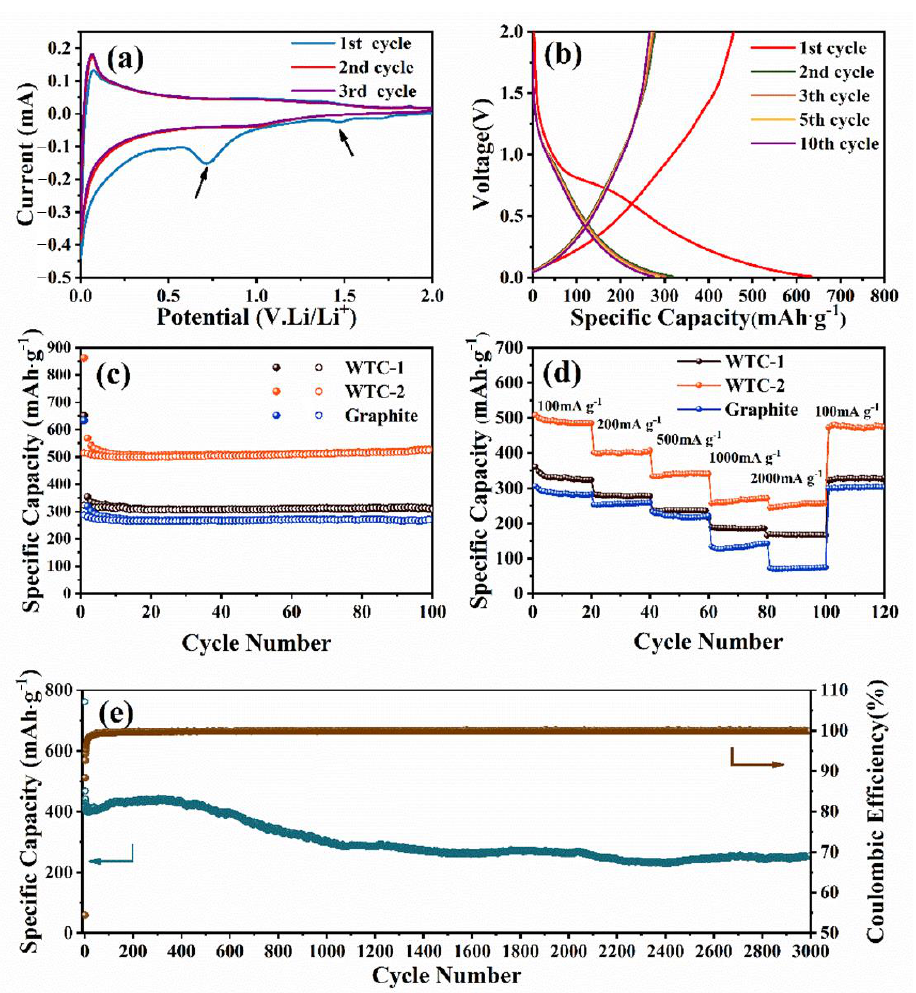
Figure 4. Electrochemical properties of the prepared samples: cyclic voltammograms for the first three cycles of ( a ) WTC-2 at a scan rate of 0.1 mV·s −1 for the range 0–2.0 V; ( b ) initial discharge- three cycles of ( a ) WTC-2 at a scan rate of 0.1 mV · s − 1 for the range 0–2.0 V; ( b ) initial discharge-charge charge curves at 100 mA·g −1 ; ( c ) cycling performance at 100 mA·g −1 ; ( d ) rate performances of WTC- curves at 100 mA · g − 1 ; ( c ) cycling performance at 100 mA · g − 1 ; ( d ) rate performances of WTC-1, 1, WTC-2, and graphite and ( e ) long-term cyclic performance of WTC-2 at 1000 mA·g −1 . WTC-2, and graphite and ( e ) long-term cyclic performance of WTC-2 at 1000 mA · g − 1